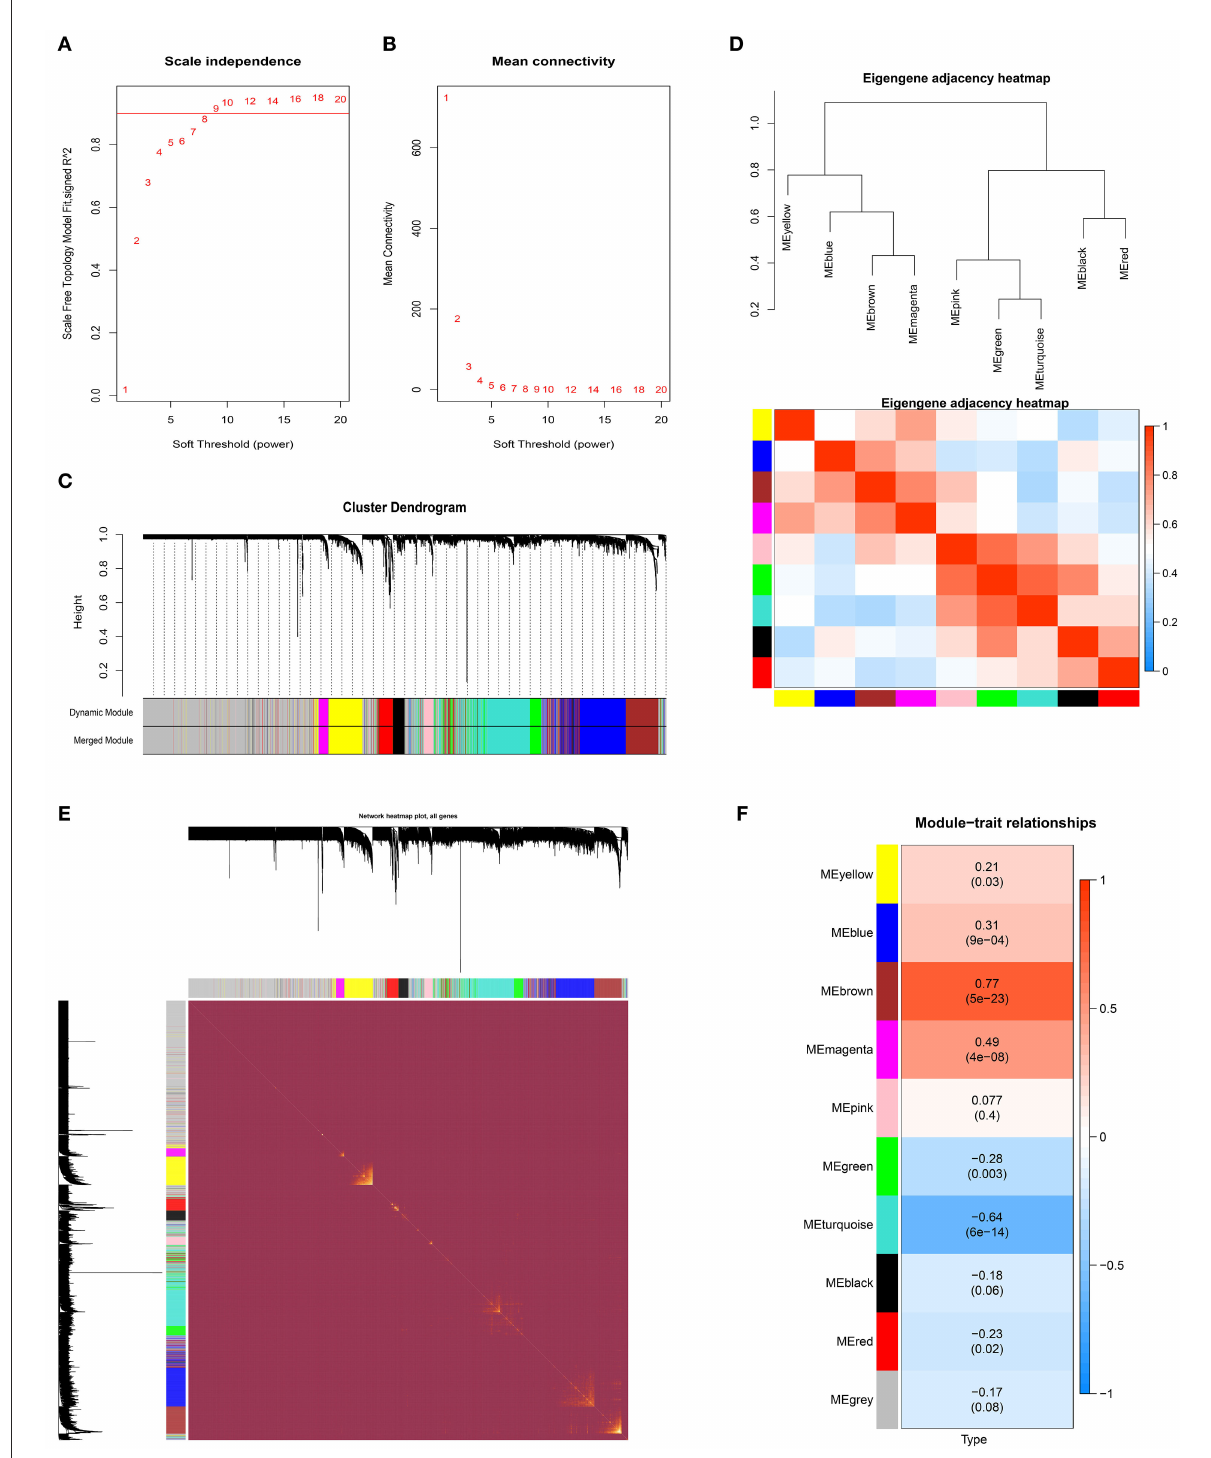
FIGURE2 The weighted gene co-expression network analysis of sarcoidosis. (A) Scale-free topological model fit at various soft-thresholding powers. (B) Mean connectivity for different soft-thresholding powers of the network. (C) Gene clustering dendrograms based on hierarchical clustering under optimal soft-thresholding power. (D) The heatmap of the eigengene adjacency. (E) The heatmap of the topological overlap matrix of genes selected by WGCNA. (F) The relationships between MEs and